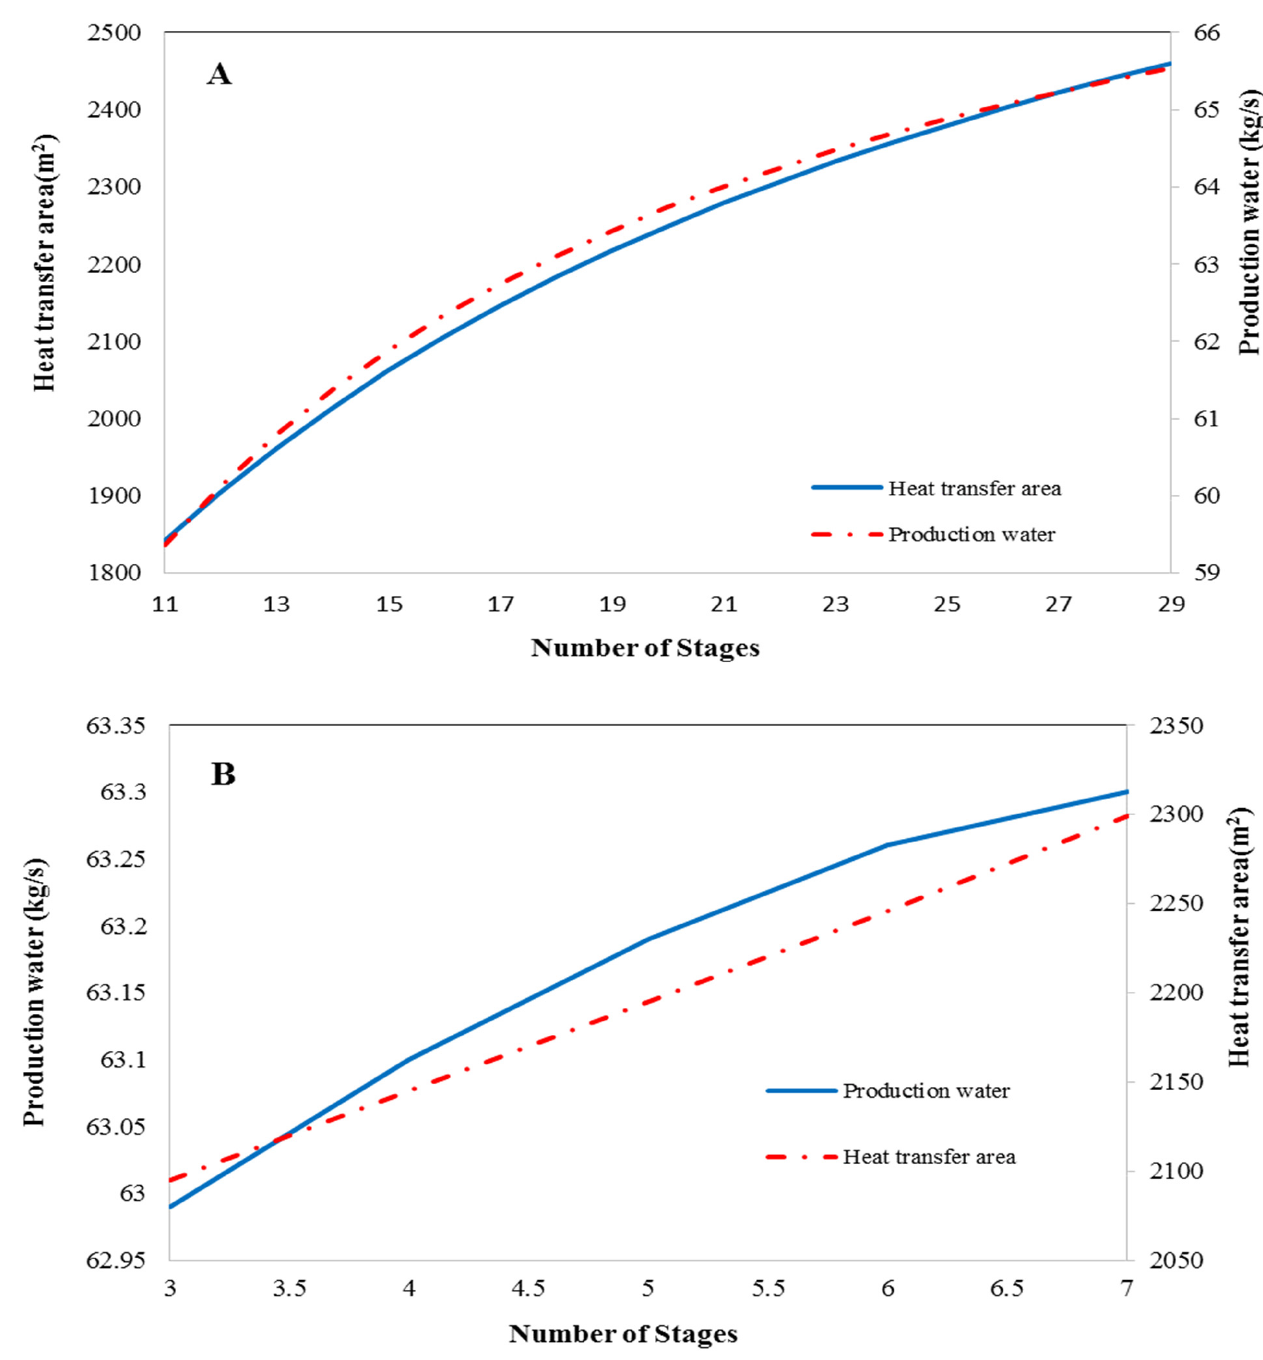
Figure 9. Variations of production water and heat transfer area in terms of the number of stages for ( A ) heat recovery section and ( B ) heat rejection ( A ) heat recovery section and ( B ) heat rejection section .